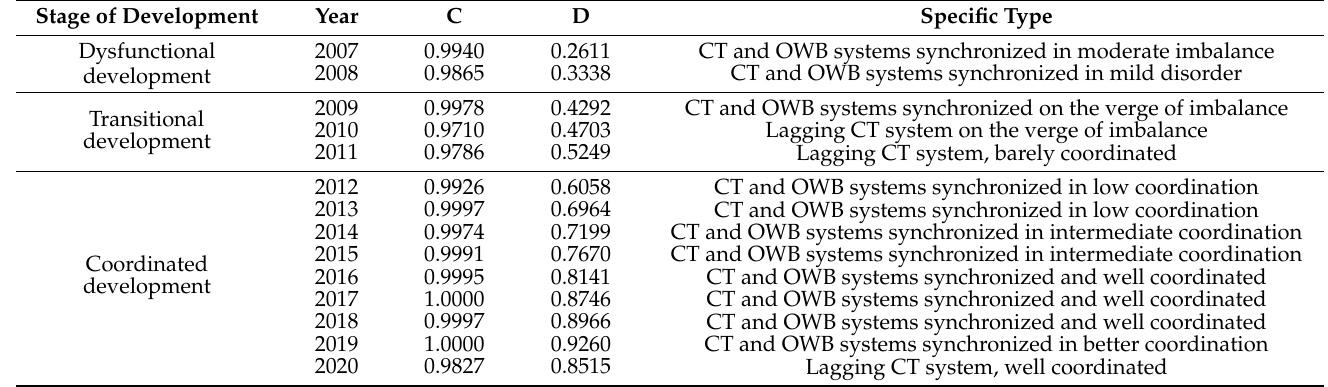
Table 5. Coupling coordination degree and type of CT and OWB systems in western China from 2007 to